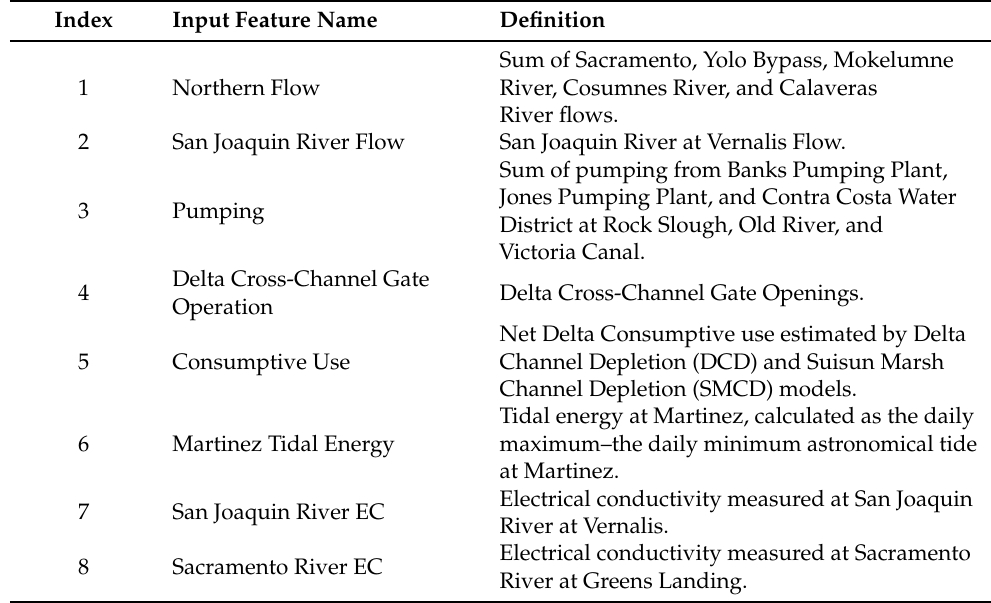
Table 1. Input features to proposed ML